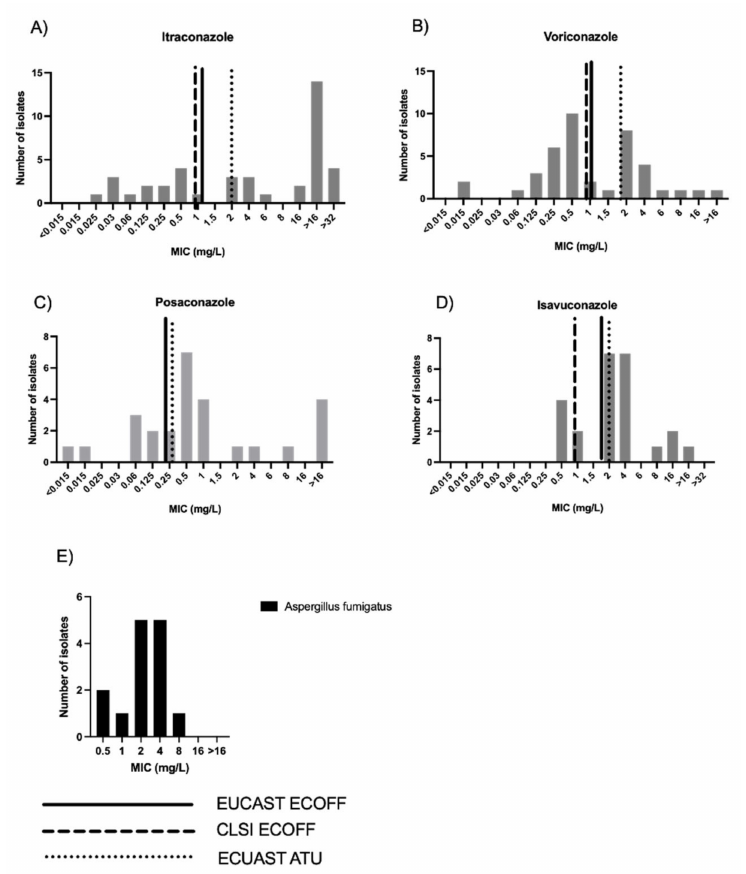
Figure 1. ( A ) Distribution of triazole MIC against all Aspergillus fumigatus clinical isolates for itra- conazole during study period; ( B ) Distribution of triazole MIC against all Aspergillus fumigatus clinical isolates for voriconazole during study period; ( C ) Distribution of triazole MIC against Aspergillus fumigatus clinical isolates for posaconazole during study period; ( D ) Distribution of tri- azole MIC against Aspergillus fumigatus clinical isolates for isavuconazole during study period; ( E ) Distribution of isavuconazole MIC (mg/L) for Aspergillus fumigatus isolates only in individuals who received isavuconazole during the study period (total of 14 isolates). Values higher than the ECOFF values are considered to be resistant. EUCAST = European Committee for Antimicrobial Susceptibility Testing. ECOFF = epidemiologic cut-off values. ECOFFs are MICs or disk diffusion zone diameters that separate organisms into those “with and without phenotypically detectable resistance”. ATU = area of technical